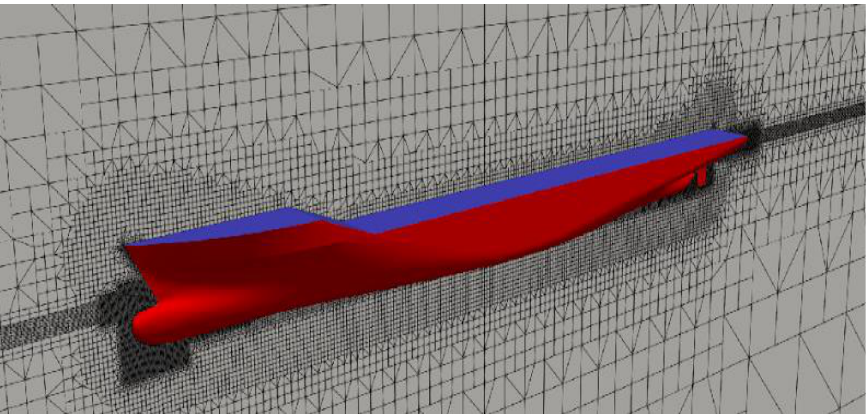
Figure 14. CFD computational domain of the KRISO containership in calm water conditions: ( a ) Kelvin wake refinements; ( b ) boundary layer.